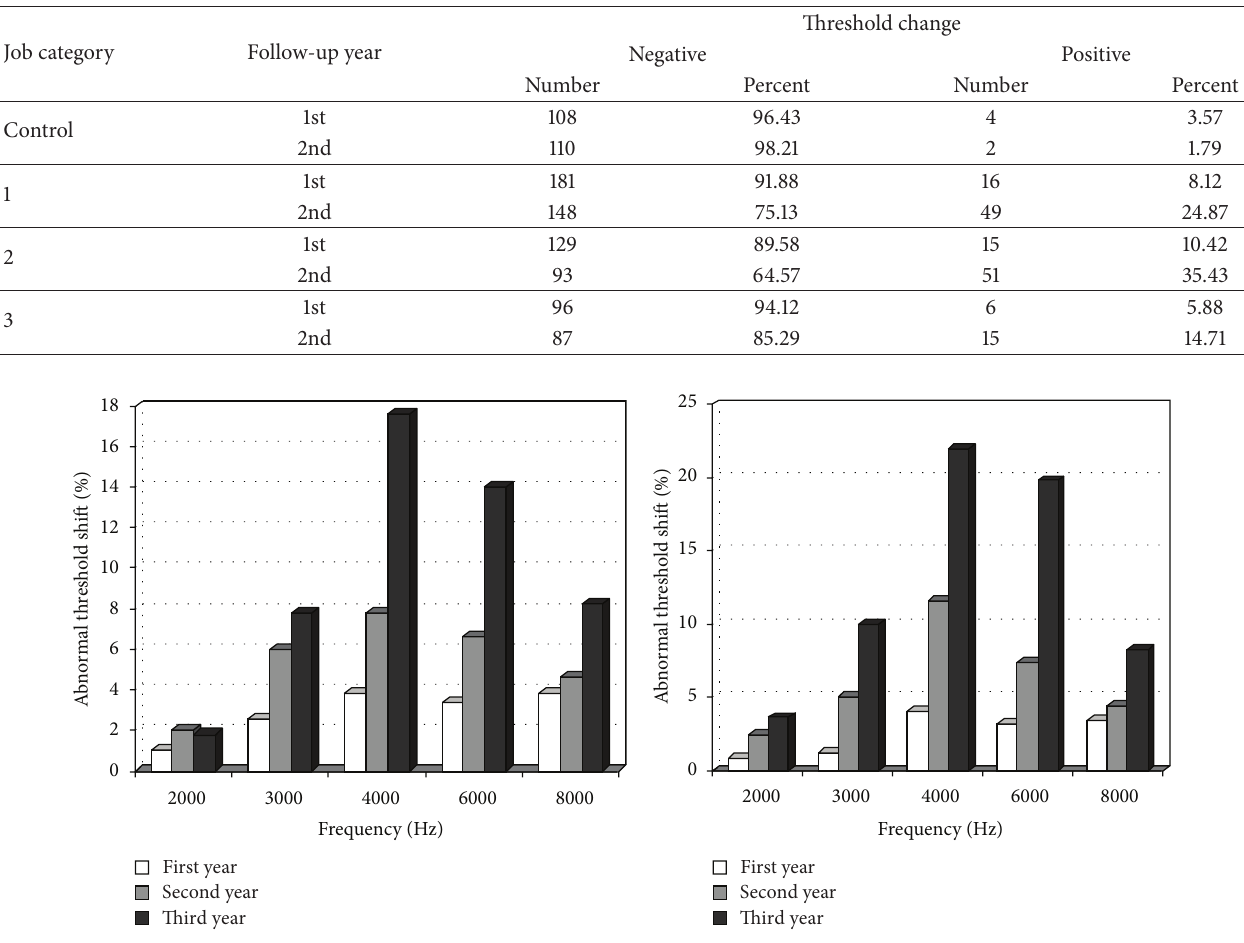
Table 3: Prevalence of mean threshold change at 3000, 4000, and 6000 Hz in each job category.